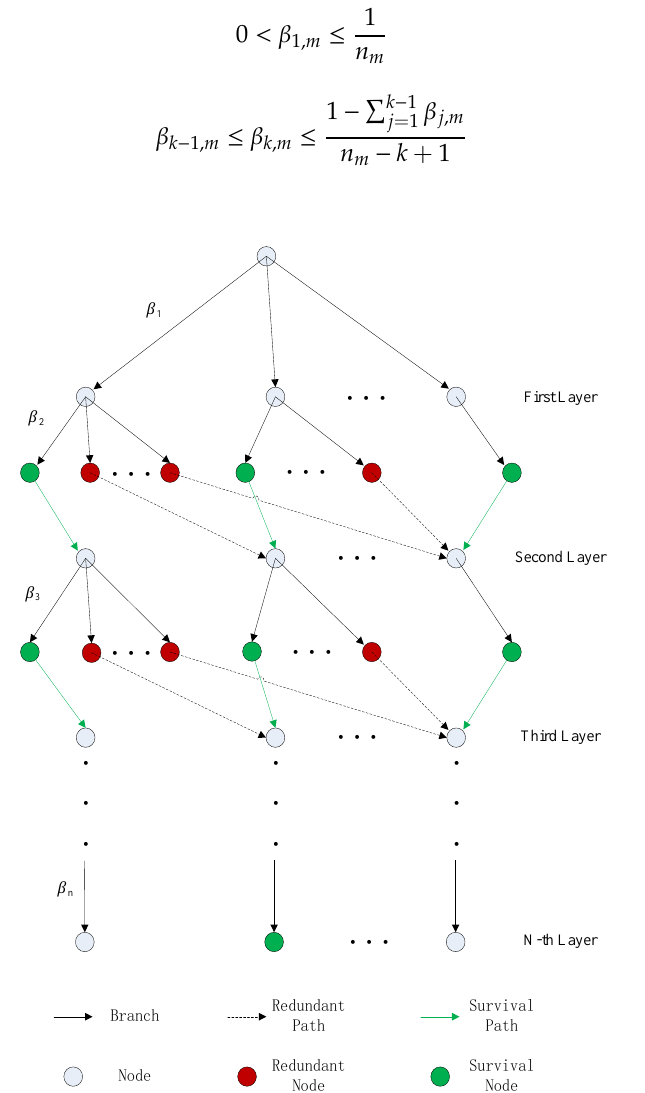
Figure 2. Propose a tree model and find a final path to allocate power to each CU through the tree-based search method. In each layer the nodes are divided into several groups to pick out the best node for the next layer.